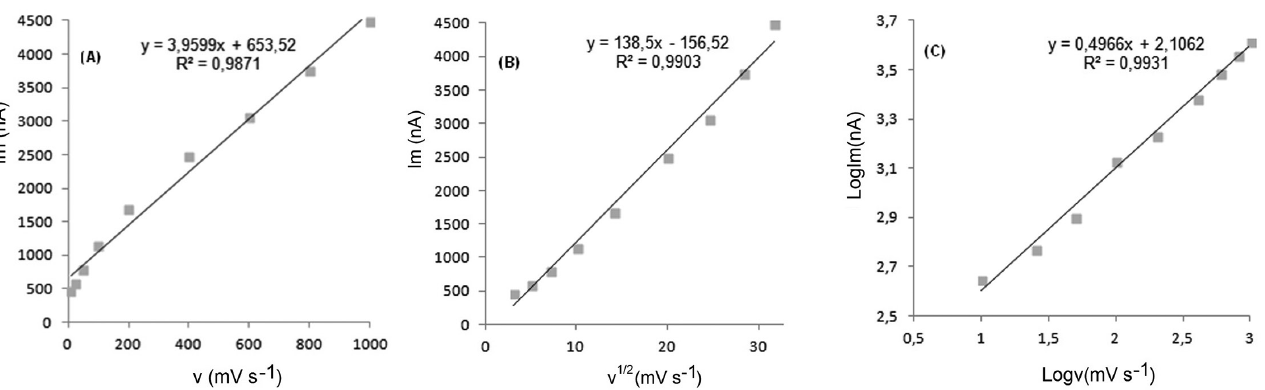
FIGURE 4 - A, B, C: Dependence of peak current on the scan rate (20 μg mL -1 ).